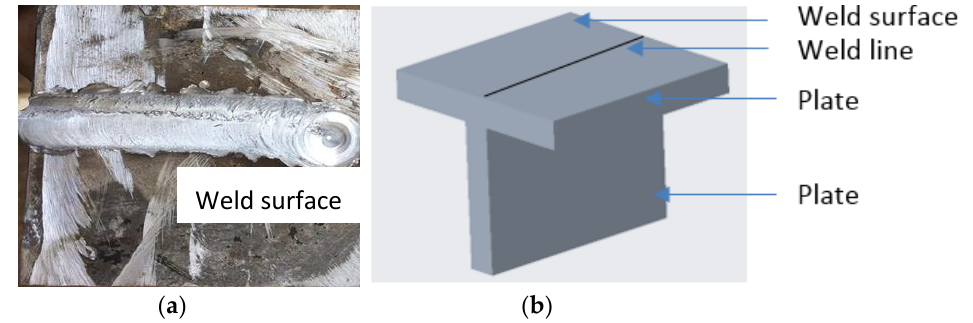
Figure 6. ( a ) Surface of T-joint after welding operation with burrs. ( b ) Schematic figure of the T-Joint.